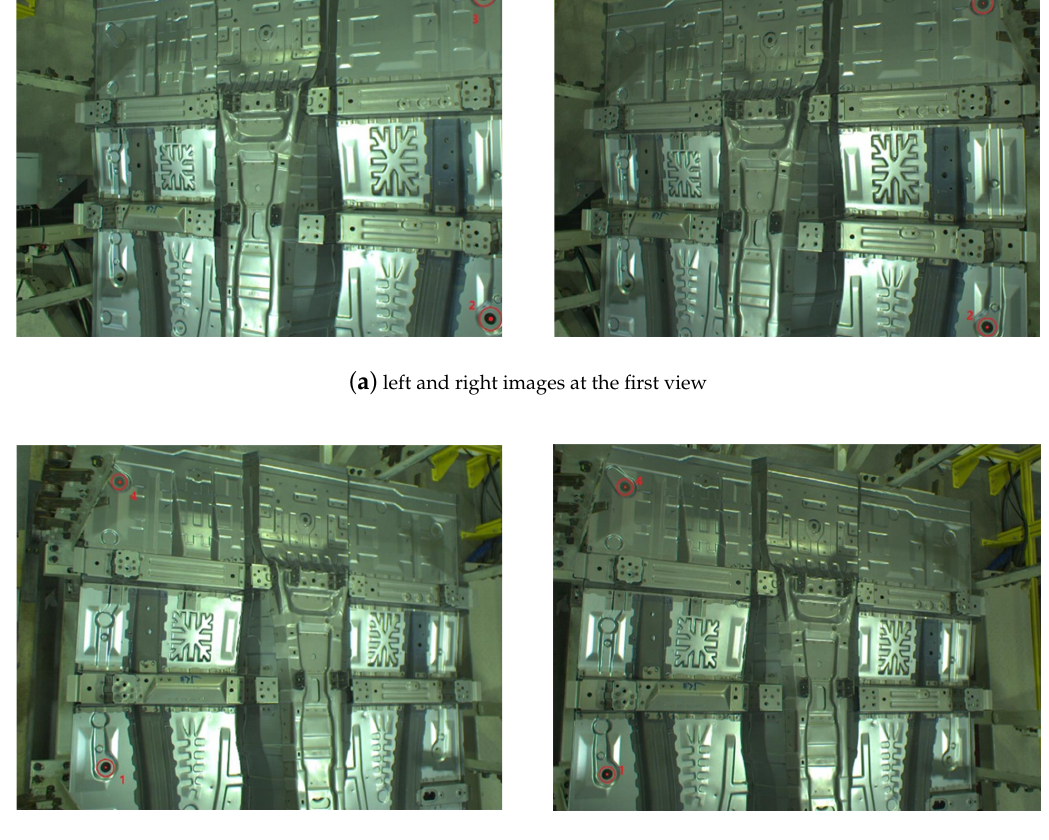
Figure 11. Two images (left camera and right camera) are captured at the first view (first row) and the second view (second row). Feature points 2 and 3 are measured at first view. Feature points 1 and 4 are measured at second view: ( a ) left image and right images at the first view; ( b ) left and right images at the second